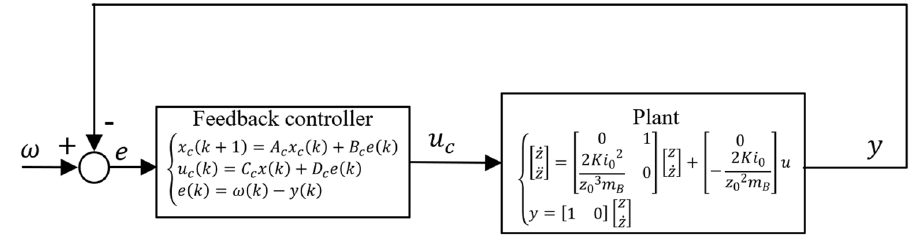
Figure 3. The structure of the feedback control.